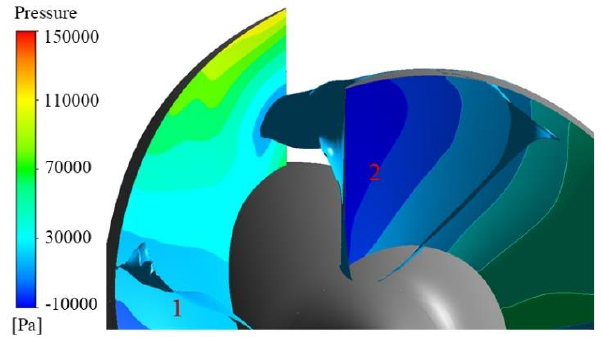
Figure 9. Pressure iso-surface of impeller passage at 8/12 T ( δ = 0.2 mm).